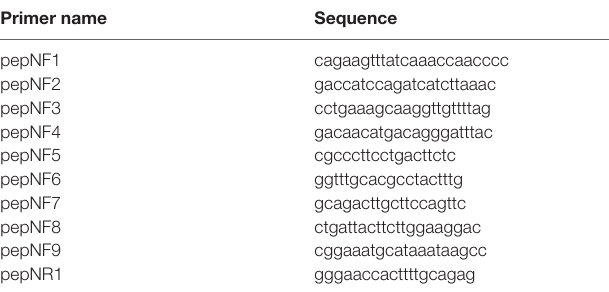
Table 2 | Primers used for sequencing pepn